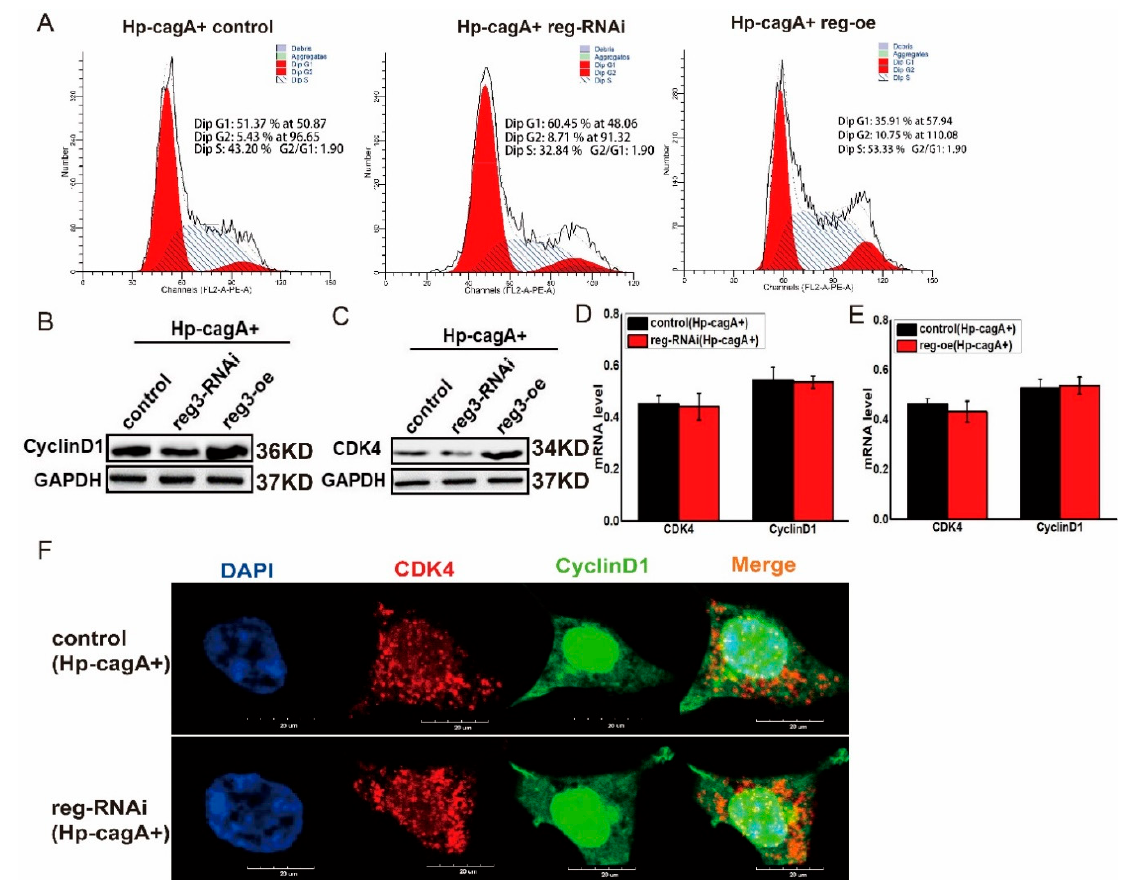
Figure 6. CagA and reg3 regulate the expression of CDK4 and CyclinD1 . ( A ). In HP-CagA+-infected gastric cancer cells, the cell cycle was detected after downregulation and upregulation of reg3. ( B ). In HP-CagA+-infected gastric cancer cells, the expression of CDK4 was detected when reg3 expression was altered. ( C ). In HP-CagA+-infected gastric cancer cells, the expression of Cyclin D1 was detected when reg3 expression was altered. ( D ). The mRNA level of CDK4/CyclinD1 were examined after downregulation of reg3 expression in HP-CagA+-infected gastric cancer cells. ( E ). The mRNA level of CDK4/CyclinD1 were examined after upregulation of reg3 expression in HP-CagA+-infected gastric cancer cells. ( F ). Immunofluorescence was used to detect the effects of HP-CagA+ and reg3 on the expression and distribution of CDK4 and cyclinD1.